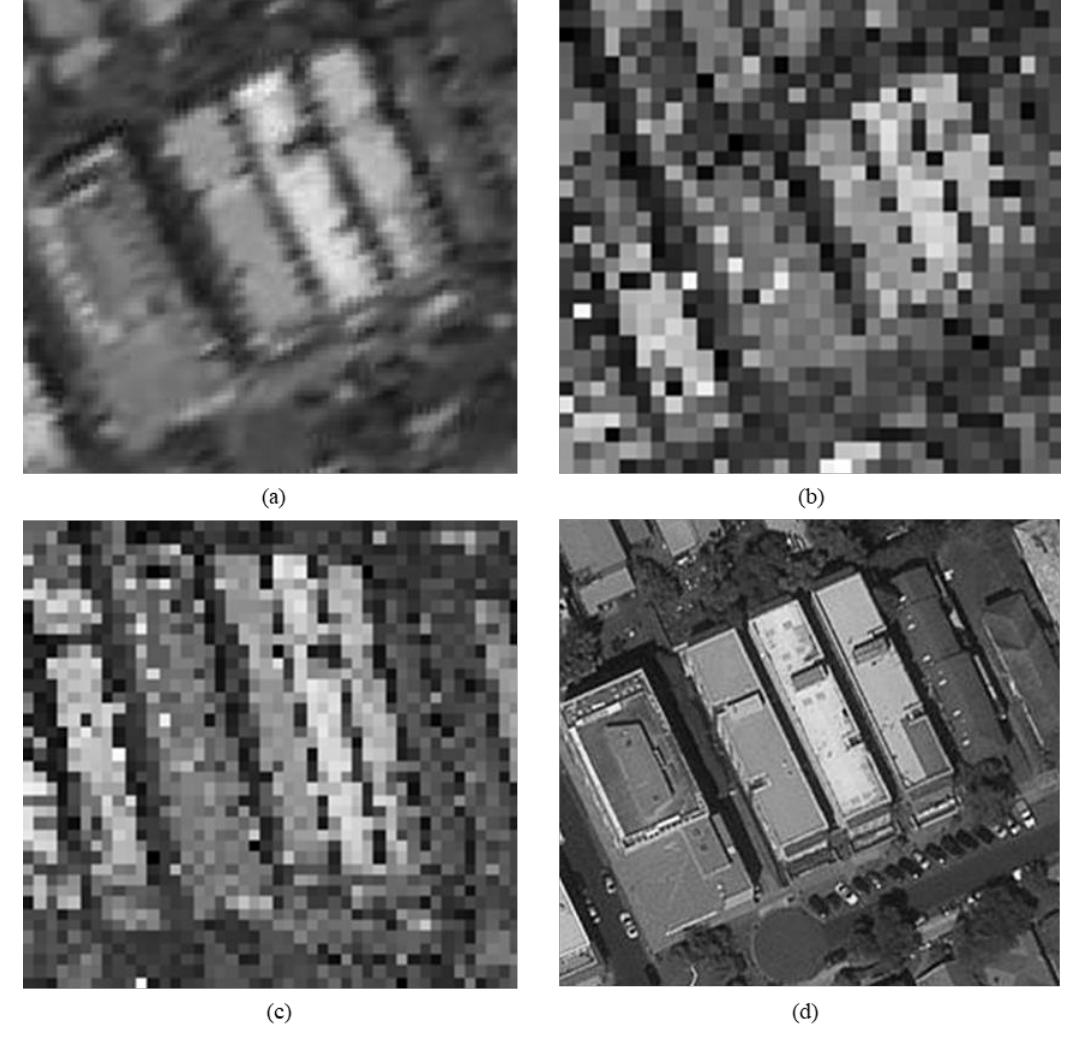
Figure 16. The local magnification of the city remote-sensing image: ( a ) super-resolution image, ( b ) conventional mode simulation image, ( c ) CMOS1 oblique-mode simulation images, ( d ) original high-resolution image.